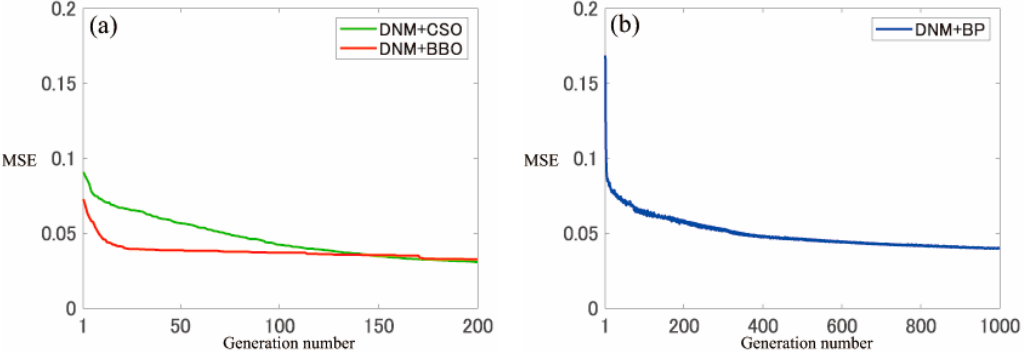
Figure 4. Convergence graphs of F2. ( a ) DNM + BBO and DNM + CSO, ( b ) DNM + BP.